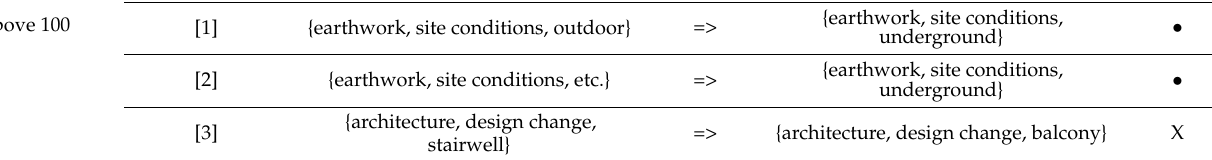
Table 3. Association rule classification system through expert